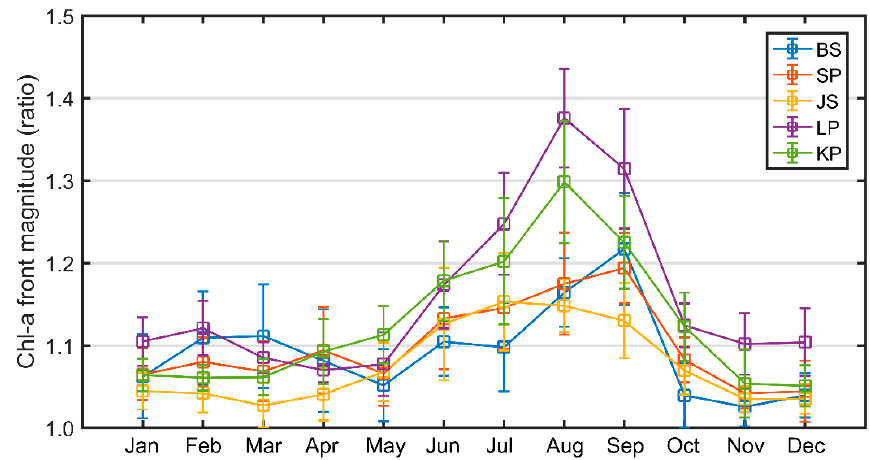
Figure 6. Monthly magnitude of the five chl-a fronts depicted in Figure 4.